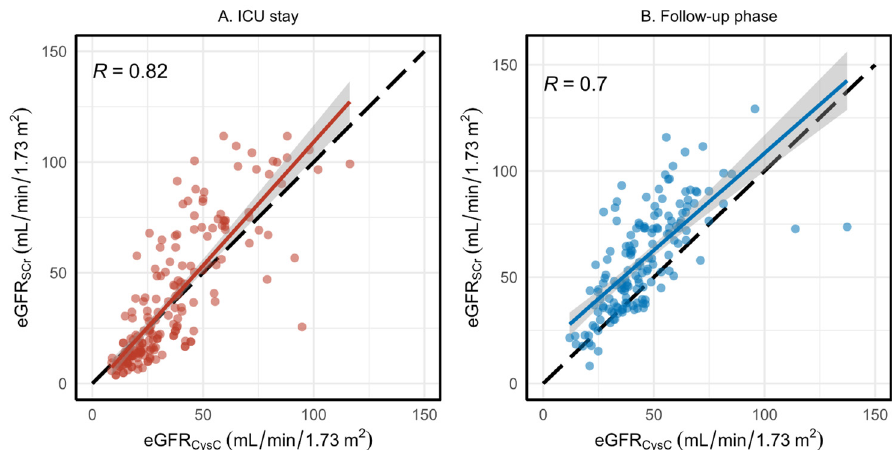
Figure 2. Estimated glomerular filtration rate (eGFR) comparison using SCr and CysC in ICU stay and follow-up phase. ( A ) shows the comparison during ICU stay and ( B ) sows the comparison during follow-up phase. The red and blue curves are fitted linear regression models in ICU and follow-up, respectively, and the faded zones are the confidence intervals around the lines. The black dashed line shows the identity line.